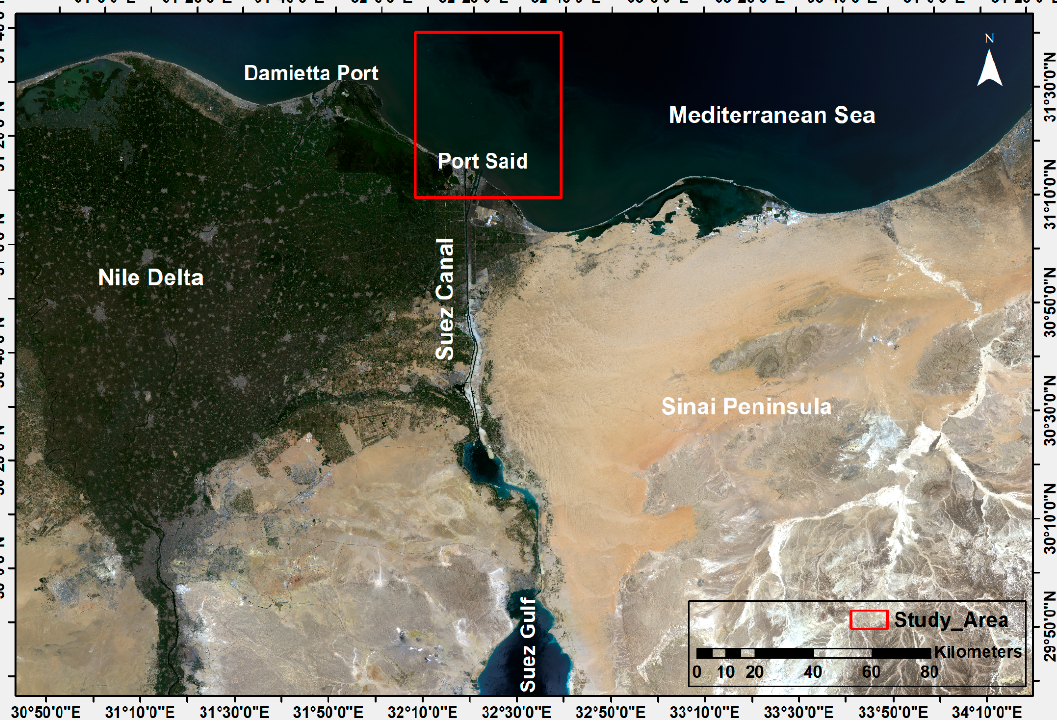
Figure 1. The area of study.